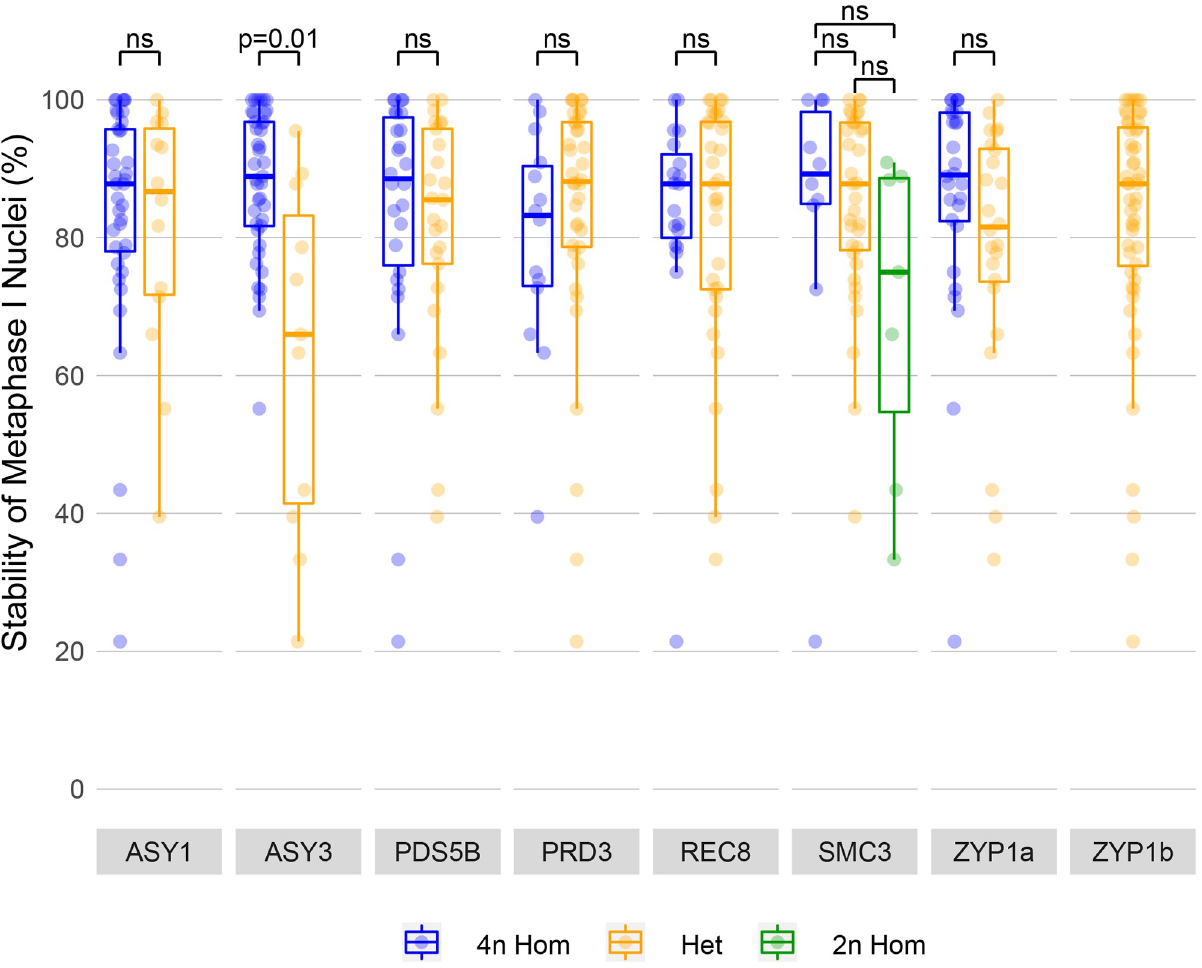
Fig 3. Association analysis of meiotic chromosome stability at metaphase I with meiosis gene haplotypes. Individual plants are collapsed into groups containing either homozygous 4n derived (blue), 2n/4n heterozygous (orange) or 2n homozygous ancestral (green) haplotypes from all populations tested. Each data point represents the male meiotic stability of an individual plant for each specific haplotype.